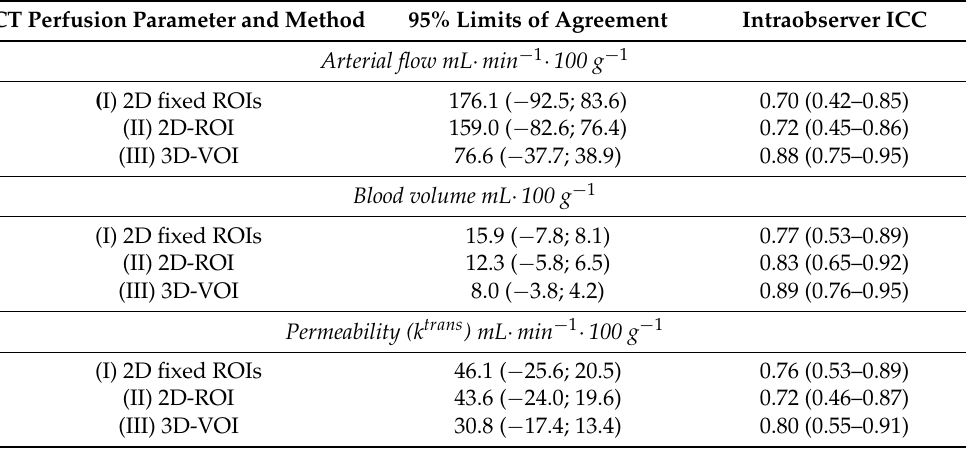
Table 2. Intra-observer reliability between readings. Span of limits of agreement and 95% limits of agreement derived from Bland–Altman